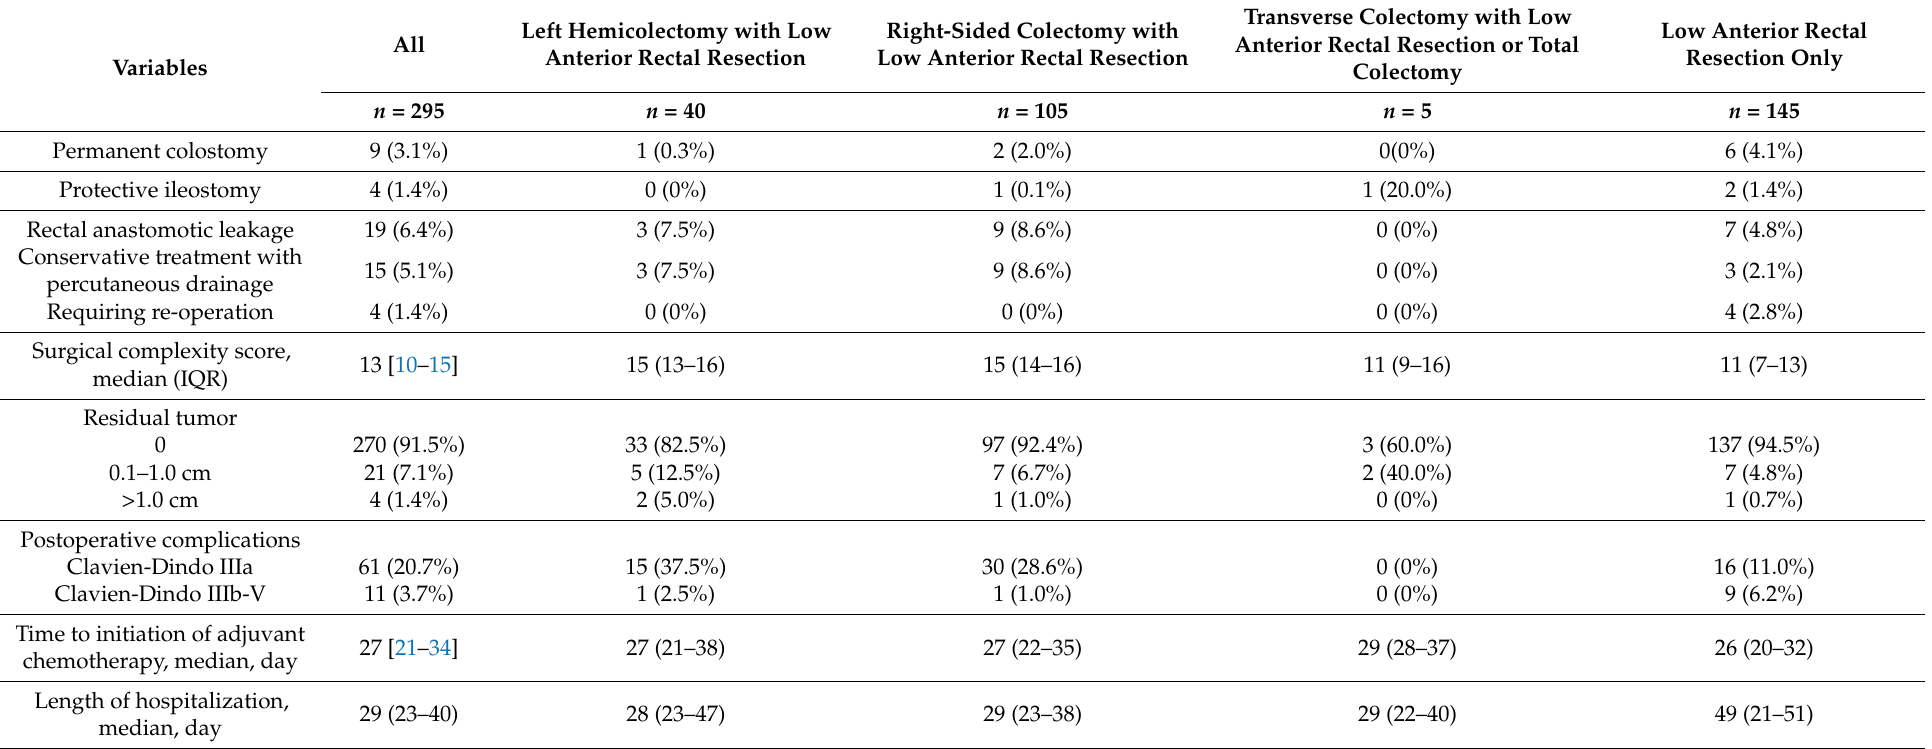
Table 2. Surgical